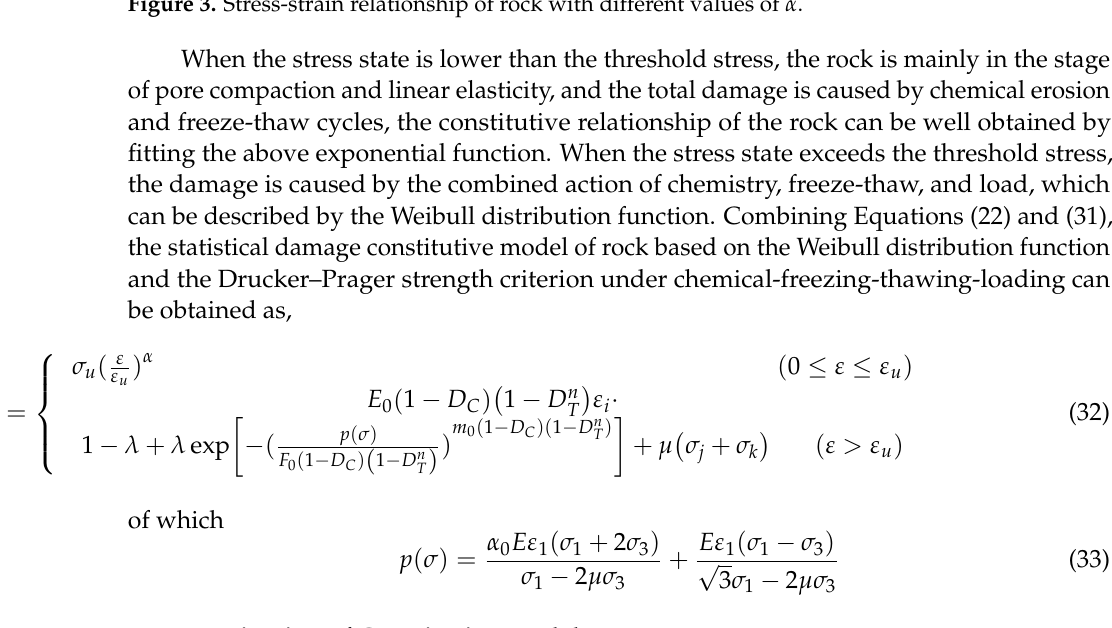
Figure 3. Stress-strain relationship of rock with different values of α